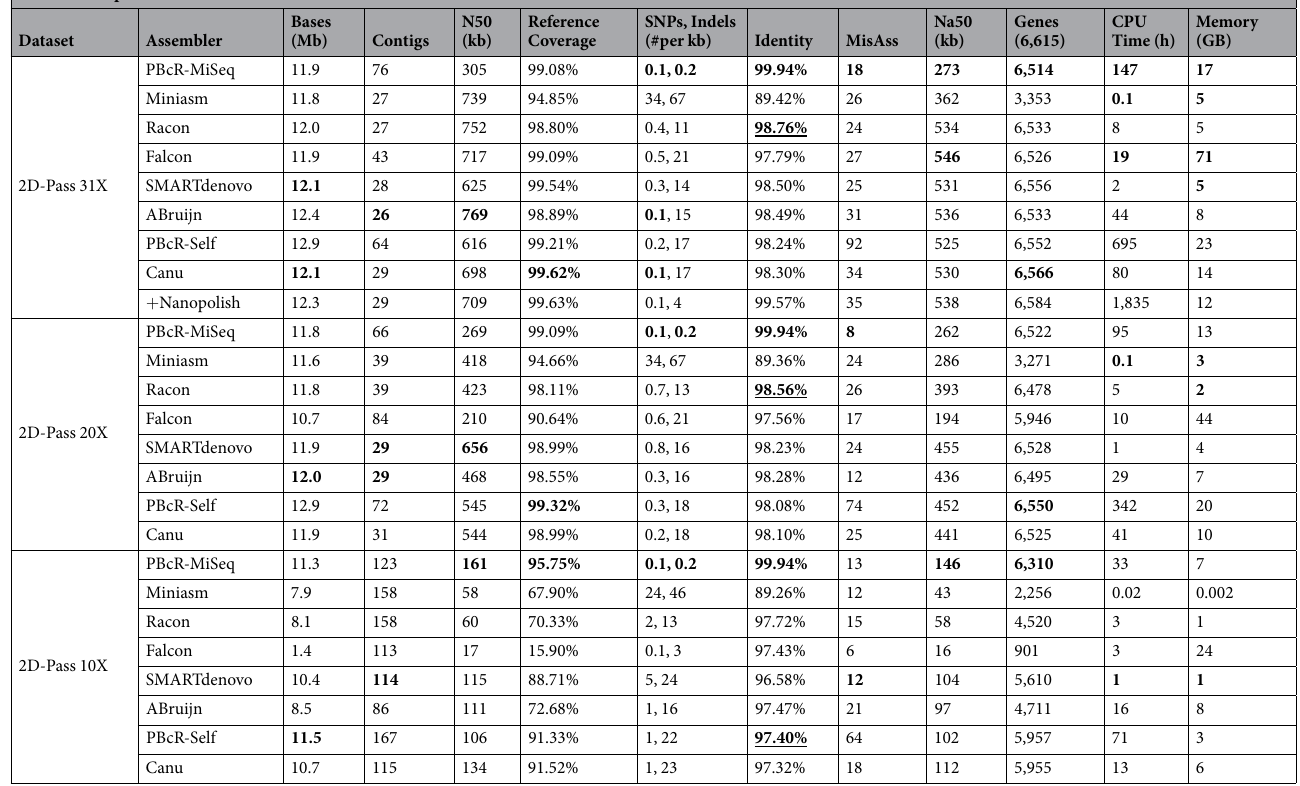
Table 3. Statistic information about the de novo assemblies for the S288C ONT datasets for the hybrid pipeline PBcR-MiSeq, the pipeline Miniasm, with no base error correction nor consensus step, and for the non-hybrid pipelines: Racon (on a Miniasm draft assembly), Falcon, SMARTdenovo, ABruijn, PBcR-Self and Canu for, from top to bottom: all the 2D-Pass reads (2D-Pass 31X), the 2D-Pass 20X subset and the 2D-Pass 10X subsets. For the 2’D-Pass 31X’ dataset also the results from Nanopolish on the Canu assembly is shown. In each column the best value is highlighted in bold. For the identity column the best value is always for the hybrid assembly PBcR-MiSeq, but we also highlighted (bold and underlined) the best value for the non-hybrid pipelines, ignoring Nanopolish as it is the only polishing tool. For the 10X datasets, we ignored assemblies with less than 80% reference coverage when choosing the best